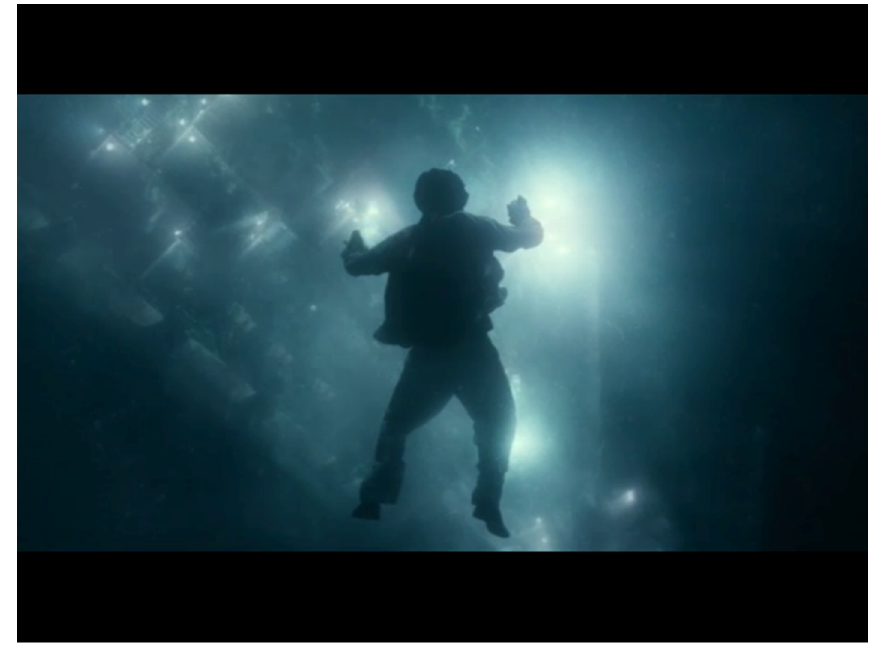
Figure 16. Pi watches the descent of the Tsimtsum .